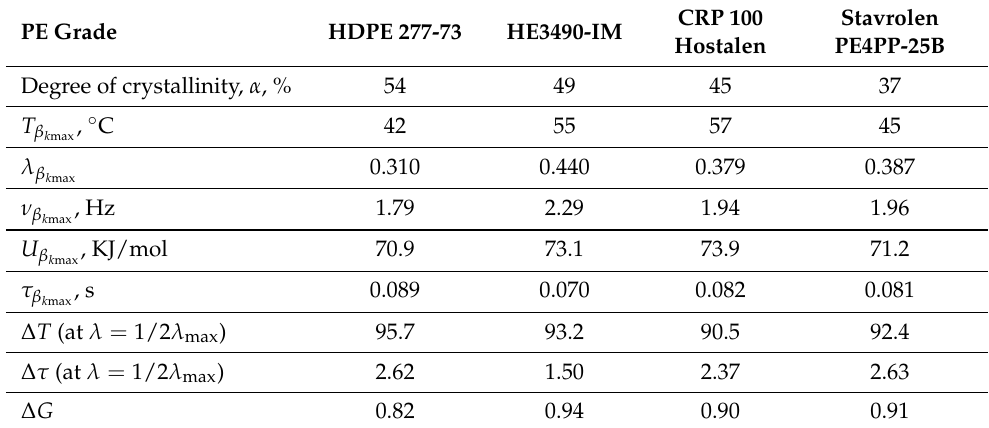
Table 2. Main physico-mechanical and physicochemical characteristics for dissipative loss process β k . PE